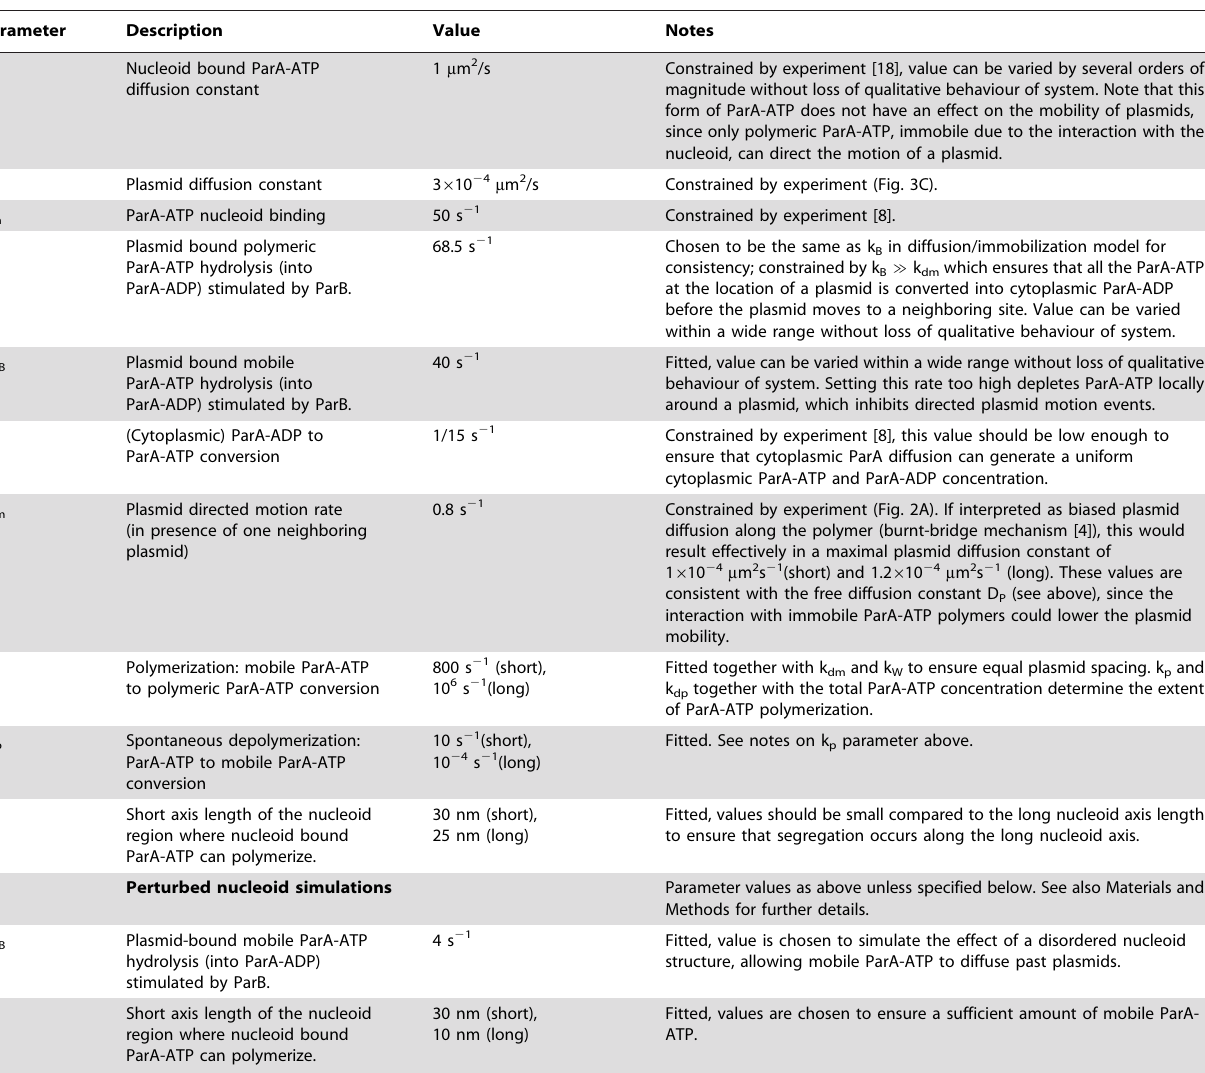
Table 4. Parameter values used in the directed motion